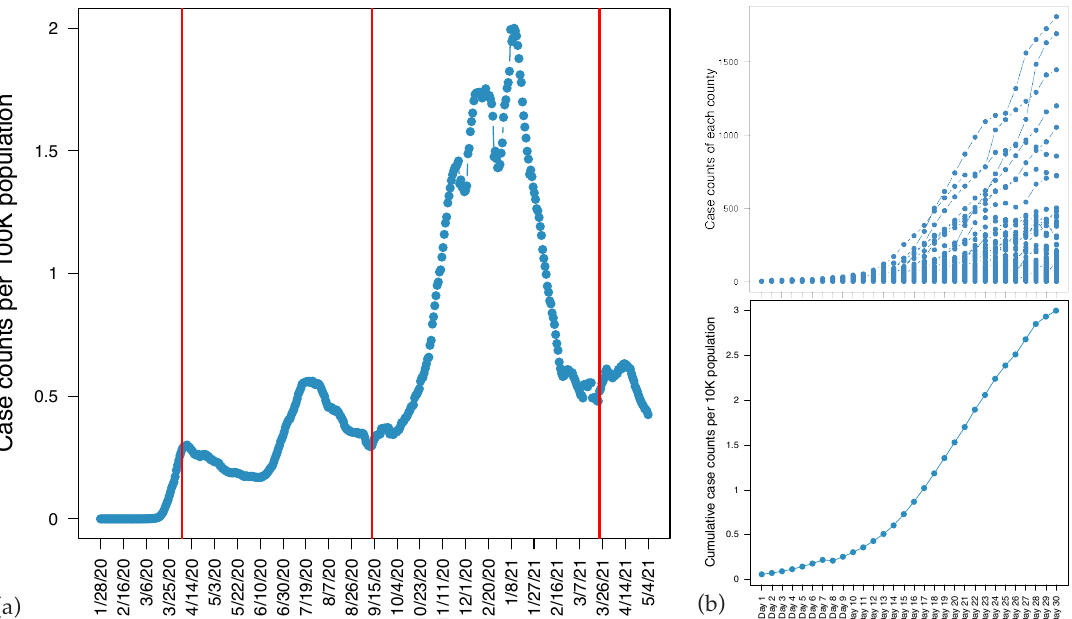
Figure A2. ( a )US-wide total 7-day moving average case counts per 100 thousand population and the dates we selected for analysis of early and late pandemic dynamics. Red lines are at 6 April 2020, 11 September 2020, and 21 March 2021. ( b ) 7-day moving average case counts of the first month with a case of each US county and US-wide cumulative case counts of the first month with a